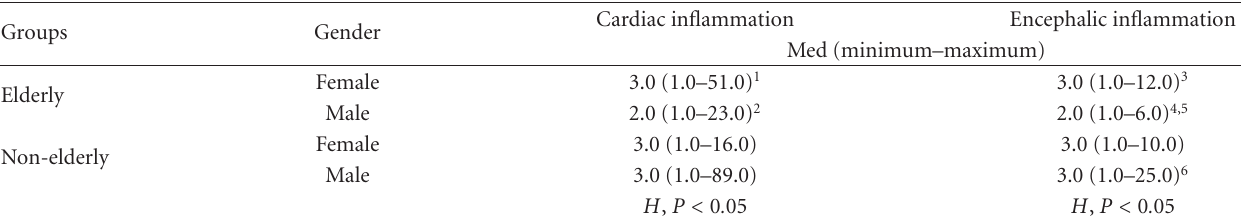
Table 3: Comparison of the inflammatory infiltrate in heart and brain in relation to the gender of non-elderly and elderly patients with